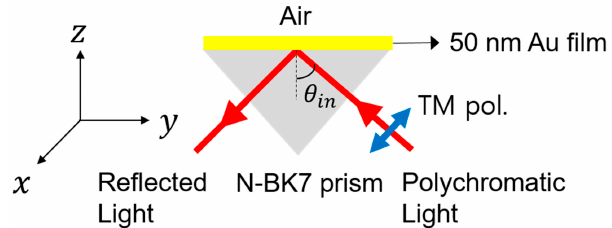
Figure 1. Schematic for ATR in a Kretschmann–Raether configuration to excite SPP at the Au film–air interface using TM polarization of light. Given an incident angle of light ( θ in ), reflectance reduces at a narrow spectral band as a result of SPP generation (wavelength interrogation